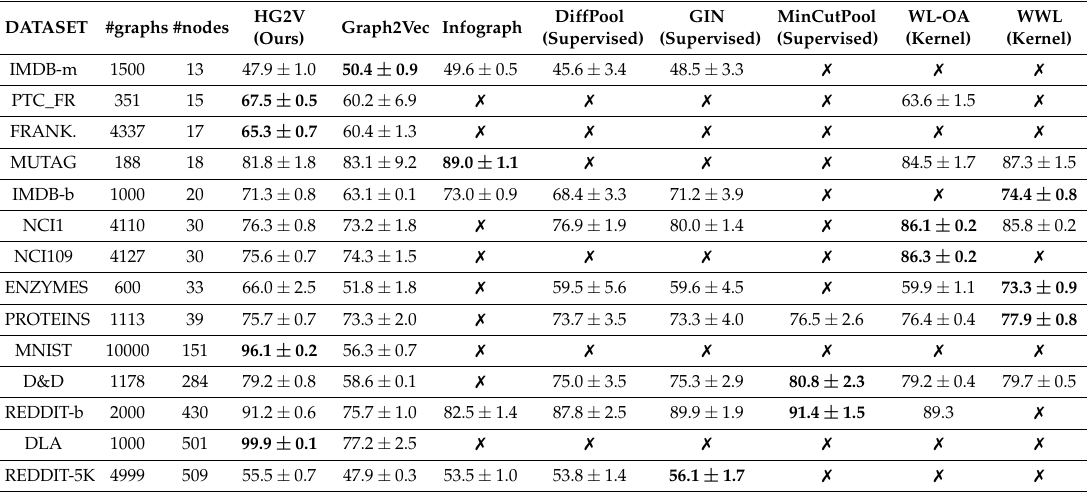
Table 2. Accuracy on classification tasks. HG2V is trained over both TrainVal+Test splits, without using labels due to its unsupervised nature. Model selection of C-SVM and hyper-parameters of HG2V have been done with 5-cross validation over TrainVal split. We report on the accuracy over the Test split, averaged over 10 runs, and with standard deviation. Unavailable result marked as (cid:55)